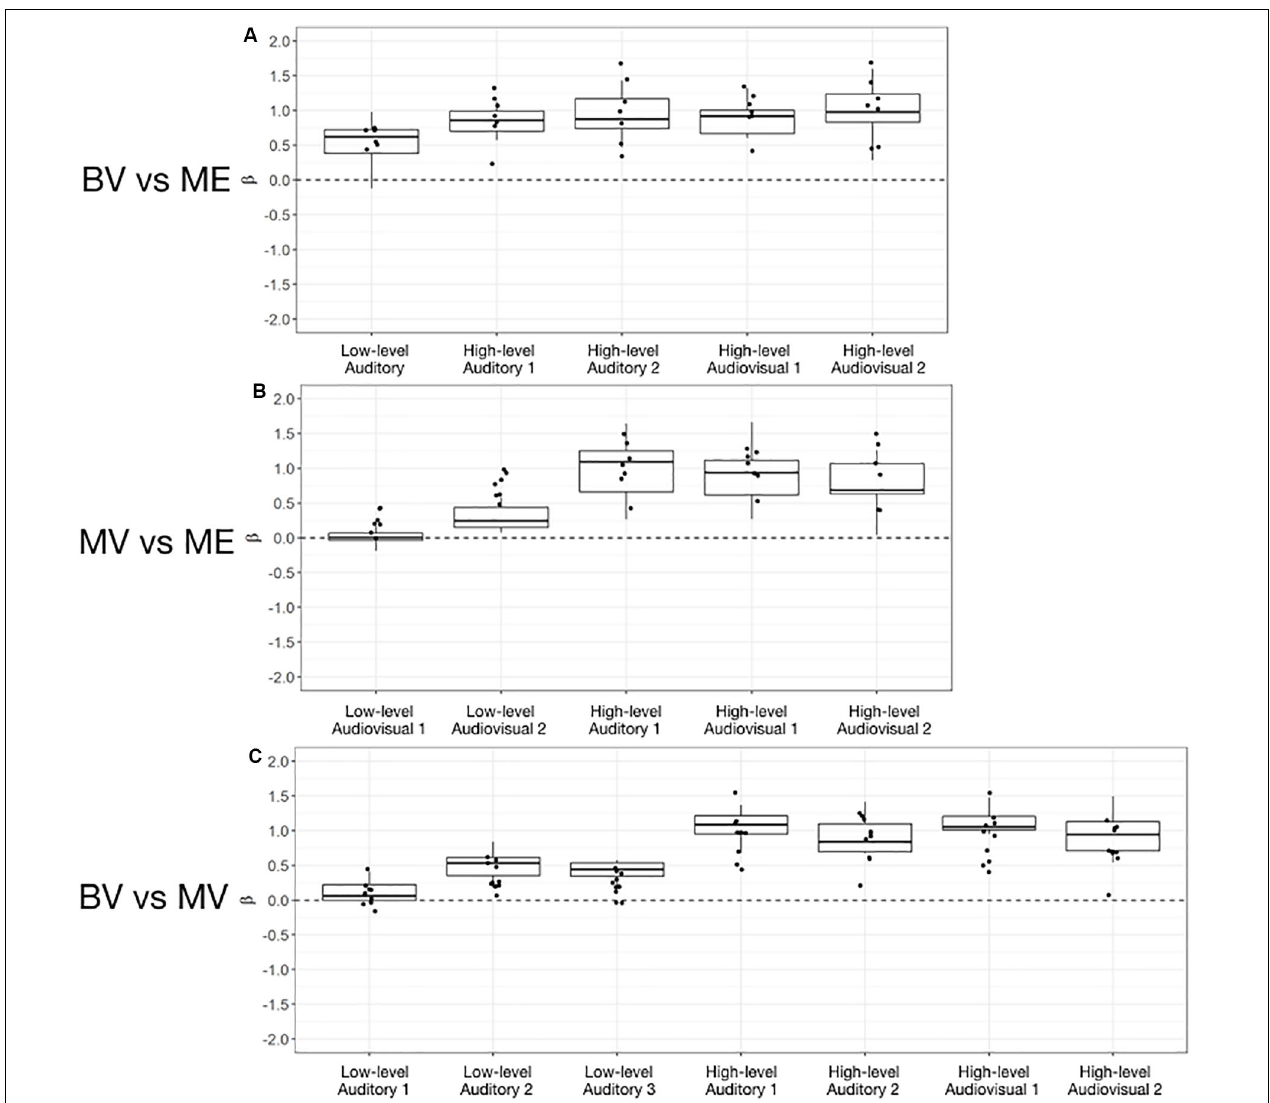
FIGURE 4 | Box and whisker plots of the distribution of peak beta weights for the control groups for the identified auditory, visual and audiovisual ROIs. The horizontal line within each box represents the median of the BV group (A,C) and the MV group (B) . The boxes correspond to the 25th and 75th percentiles, the whiskers correspond to the 5th and 95th percentiles. Individual data points for the ME group are plotted (A,B) and MV group (C)